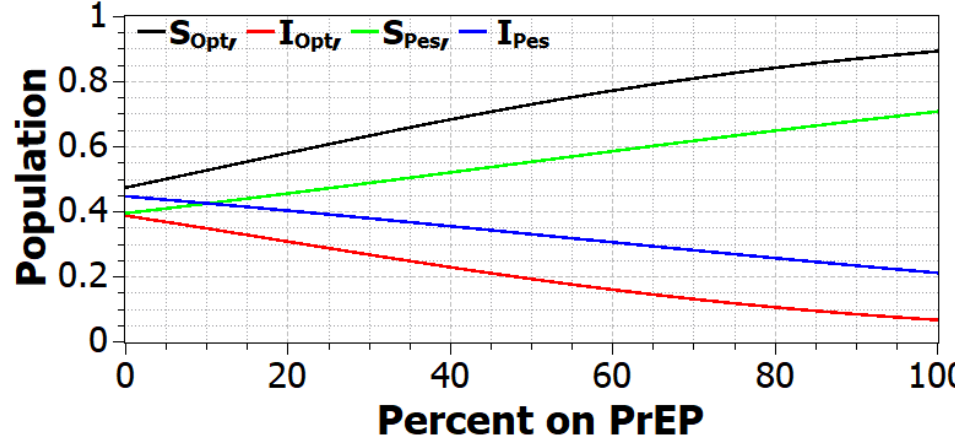
Figure 5. This plot shows total susceptible and total infected population percentages as a function of PrEP usage at the 50-year mark for the optimistic (black and red) and the pessimistic (green and blue) scenarios. This uses the assumption of two partners/year.